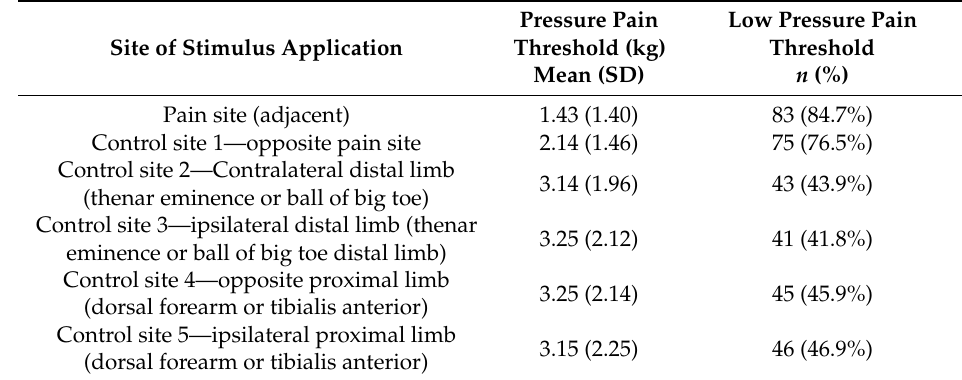
Table 4. Deep pressure pain threshold at the pain site and control sites (N = 98) and the frequency of low deep pressure pain threshold as compared with the upper limit of normative data (2.37 kg / cm 2 ) [35].